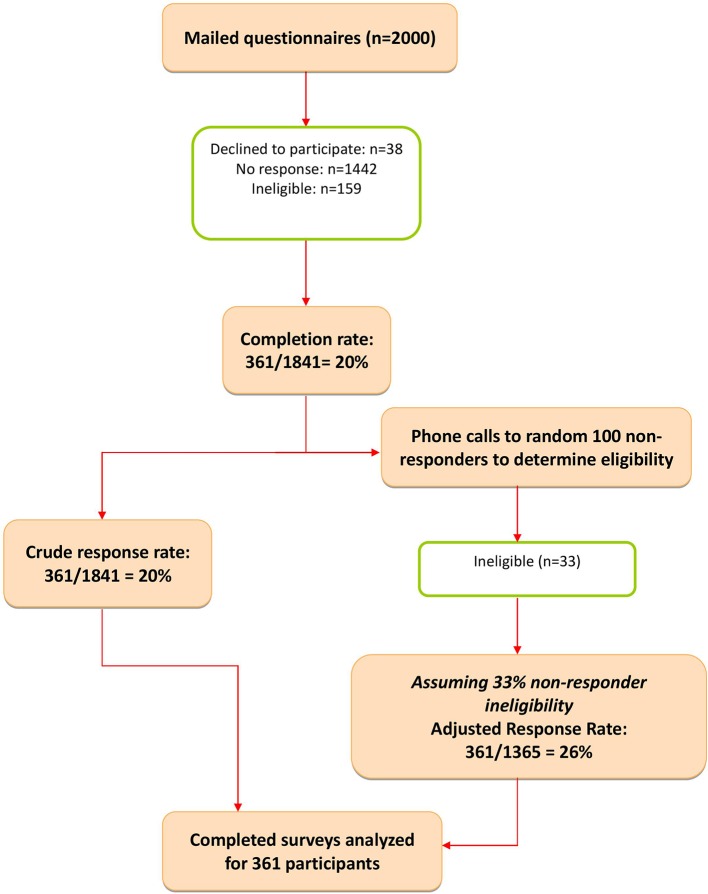
Response rate flowchart.